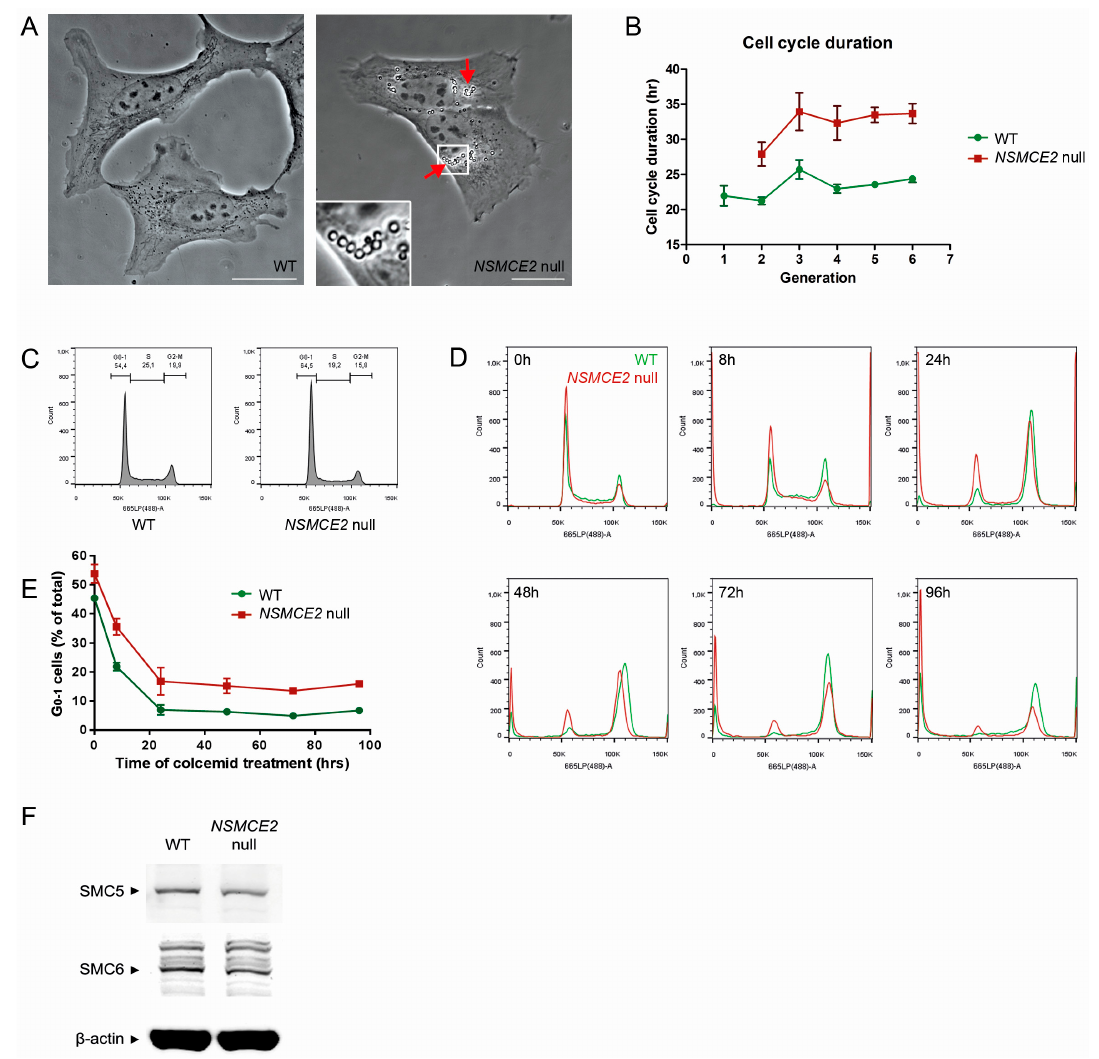
Figure 2. Analysis of NSMCE2 null cell growth characteristics: ( A ) Phase contrast images of WT and NSMCE2 null cells. The latter shows a large number of vacuoles in the cytoplasm (arrow). Bar = 20 µ m; ( B ) Average cell cycle duration of WT and NSMCE2 null cells over multiple generations observed by live cell imaging. Data are presented as mean ± standard error of mean (SEM), n = 3; ( C ) Cell cycle phase distribution analysis of WT and NSMCE2 null cells by DNA histograms shows a 10% increase NSMCE2 null cells in G 0-1 ; ( D ) G 0-1 phase depletion by colcemid treatment. WT and NSMCE2 null cells were treated with colcemid for 0–96 h. In NSMCE2 null cells, a fraction of cells remained in G 0-1 even after 96 h; ( E ) Quantification for depletion of G 0-1 cells with the time of colcemid treatment. Data